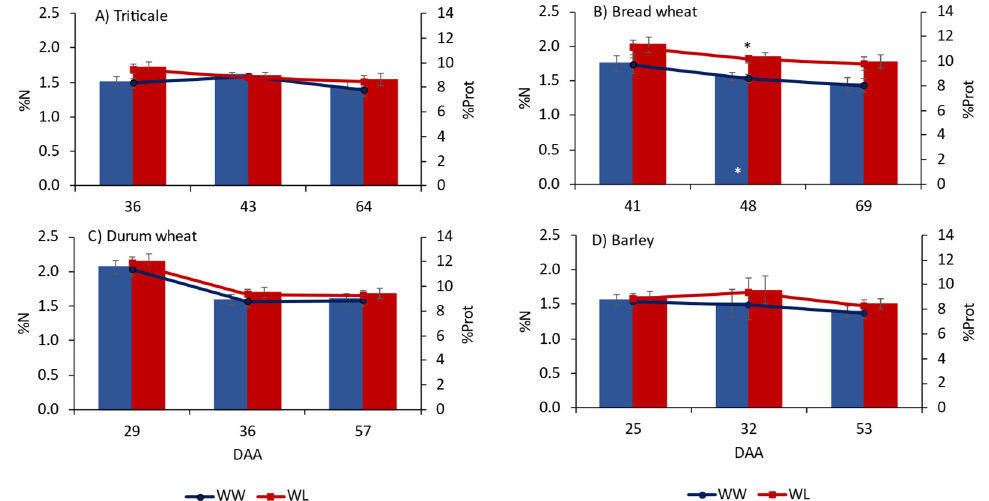
Figure 8. Percentage of nitrogen (%N; line) and protein (%Prot; bars) concentrations at three time points during grain filling (days after anthesis, DAA) in the four cereals ( A ) triticale, ( B ) bread wheat, ( C ) durum wheat, and ( D ) barley grown under well-watered (WW) and water-limited (WL) regimes. Statistical differences ( p < 0.05 *).